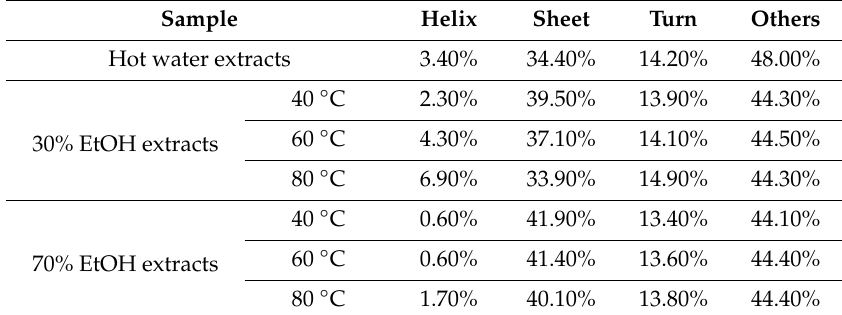
Table 1. Calculated conformations of various cocoon extracts prepared by using di ff erent solvents at di ff erent